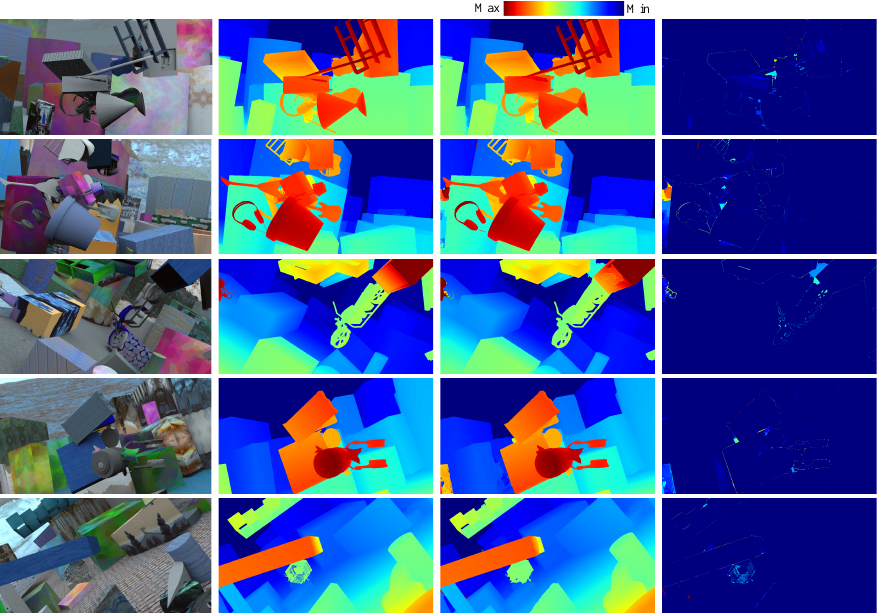
Figure 7. Disparity estimation using the SceneFlow dataset. First–fourth columns: input reference images; disparity ground truths; Dual-GANet results; and disparity error maps.